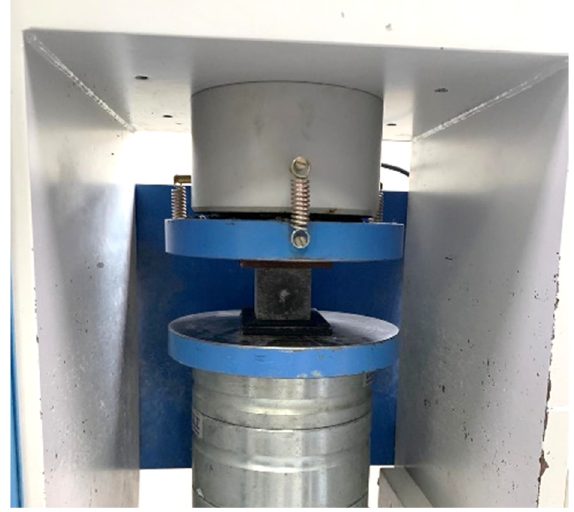
Figure 7. Mortar cube under compressive strength test.